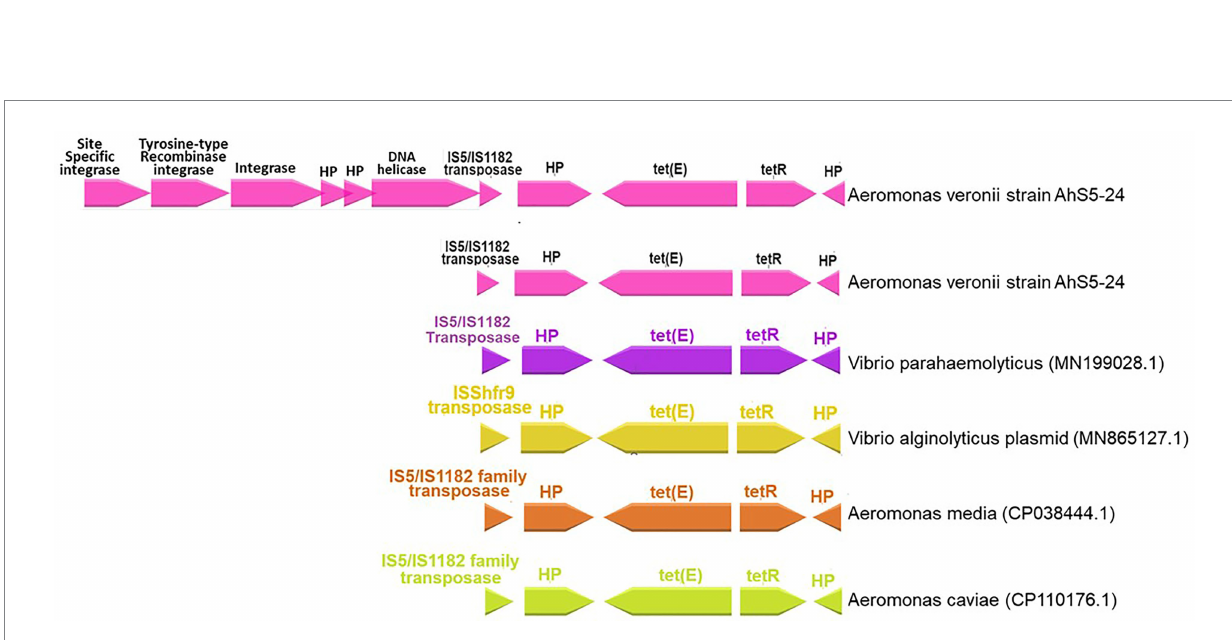
FIGURE 4 Comparison of the IS 5/ IS 1182/hp/tet(E)/tetR/hp gene cassettes for Aeromonas veronii strain AhS5-24 from pond sediments, Vibrio parahaemolyticus (MN199028) isolated from retail fish from a market, Vibrio alginolyticus plasmid (MN865127.1) from shrimp, Aeromonas media (CP038444.1) from sewage bioreactor and Aeromonas caviae (CP110176.1) from human stool. Note that all isolates had the hypothetical proteins ( hp ), tetR , tet(E), and IS 5/ IS 1182 transposase forming a gene cassette designated as IS 5/ IS 1182/hp/tet(E)/tetR/hp . The uppermost linear map shows Aeromonas veronii strain AhS5-24 having the IS 5/ IS 1182/hp/tet(E)/tetR/hp cassette linked to the DNA helicase, two hypothetical proteins, integrase, tyrosine-type recombinase/ integrase and site-specific